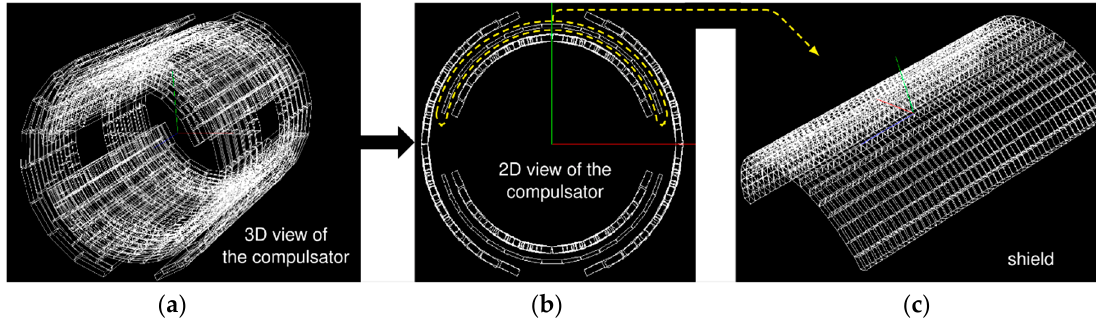
Figure 3. An example of the modeling of a compulsator by EN4EM. Snapshot of ( a ) the 3D view; ( b ) cross section of the machine; ( c ) discretization of the compensating shield. (Reproduced with permission from [29], IEEE, 2017).